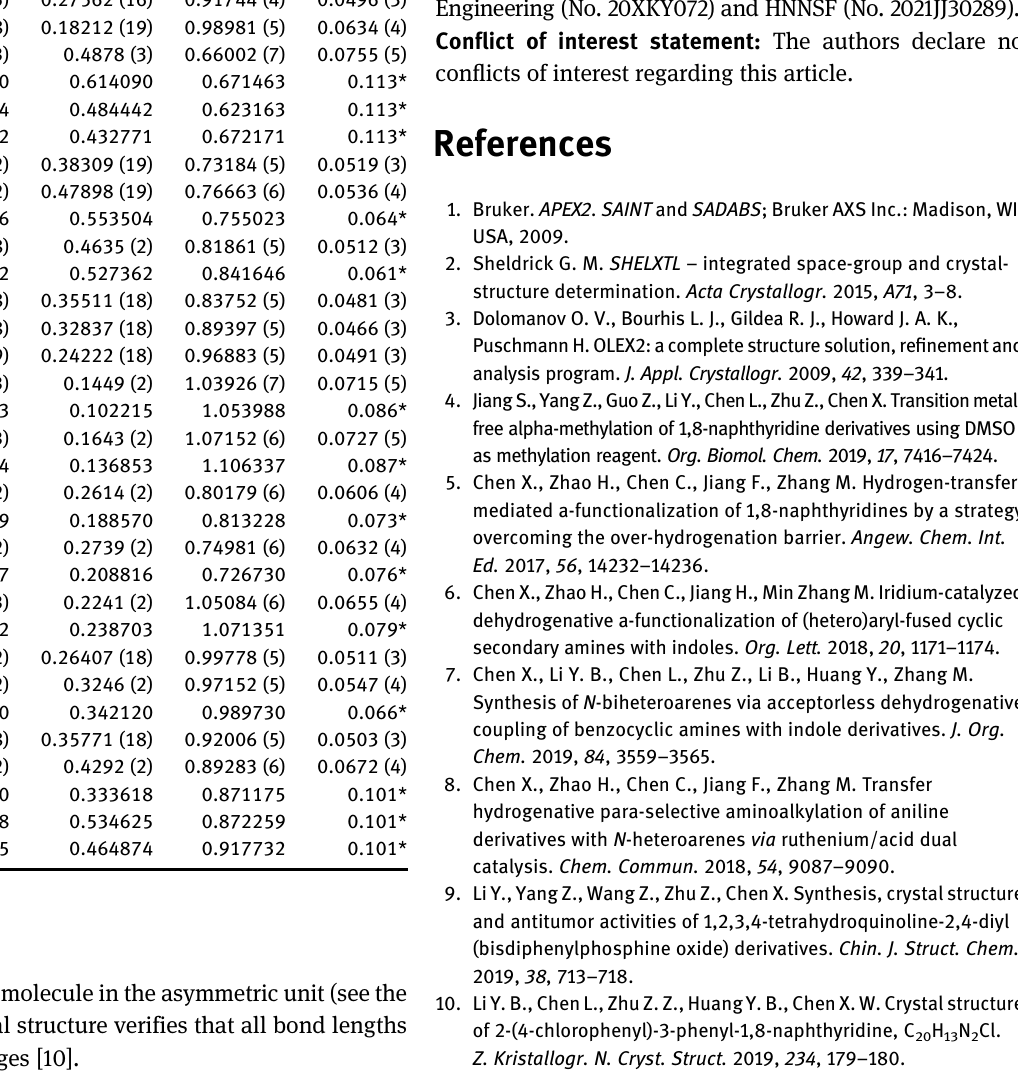
Thedre is one molecule in the asymmetric unit (see the figure). The crystal structure verifies that all bond lengths are in normal ranges [10].